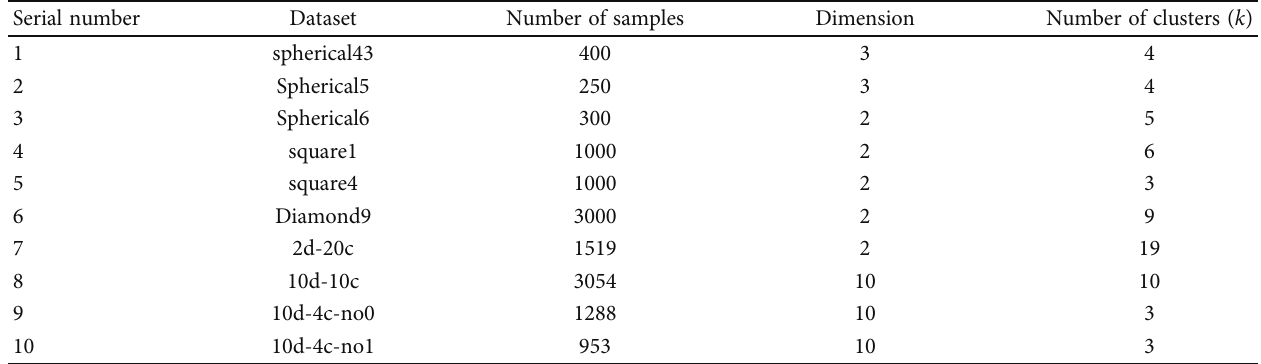
Table 1: Characteristics of datasets used in the